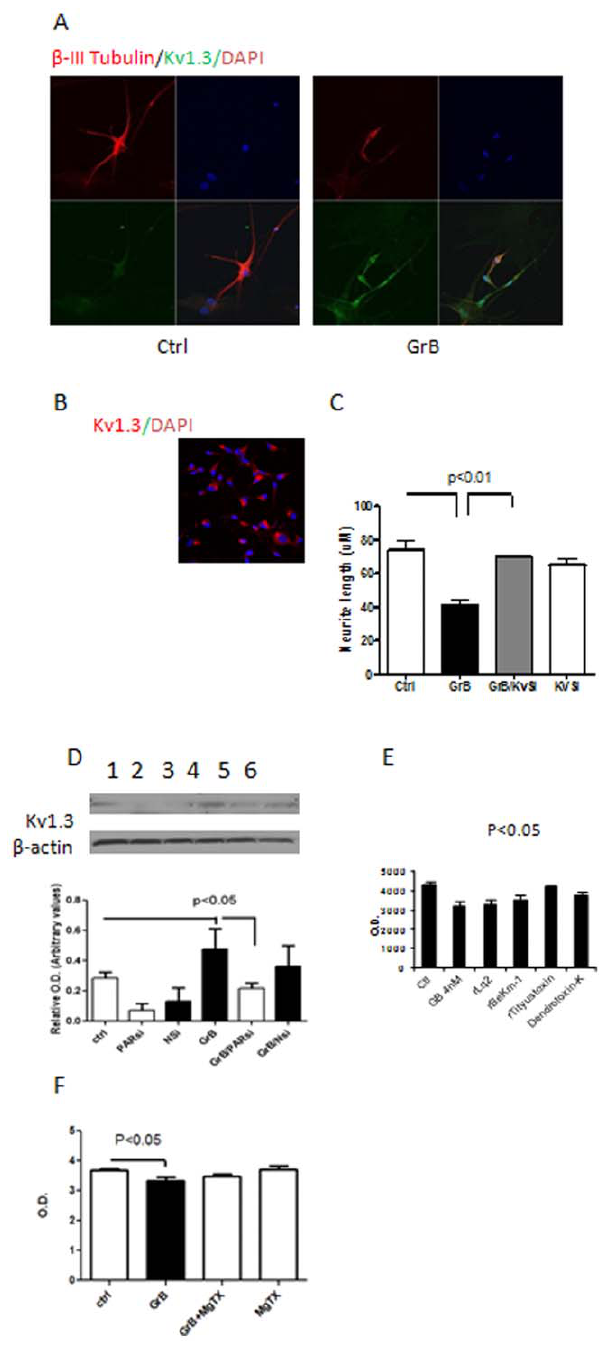
Figure 3. GrB activates Kv1.3 channel in neurons. (A) Human fetal neurons were treated with GrB (4 nM) for 24 hr. Cells were then fixed and immunostained for Kv1.3 and beta-III tubulin and analyzed by confocal microscopy. Representative photomicrographs from three independent experiments with similar results are shown. (B) Human fetal neurons were pretreated with cycloheximide (CHX, 100 m g/ml) or actinomycin D (Act D, 10 m M) for 30 min prior to GrB (4 nM) treatment. 24 hr later, cells were fixed and immunostained for Kv1.3 and analyzed by confocal microscopy. Representative photomicrographs from three independent experiments with similar results are shown. (C) Primary human neuronal cultures were first transfected with siRNA specific to Kv1.3 (KvSi). After 48 hr, GrB (4 nM) was used to treat the cells. Cells were fixed after 24 hr and immunostained for beta-III-tubulin. Neurite lengths were measured as detailed in Methods. Results